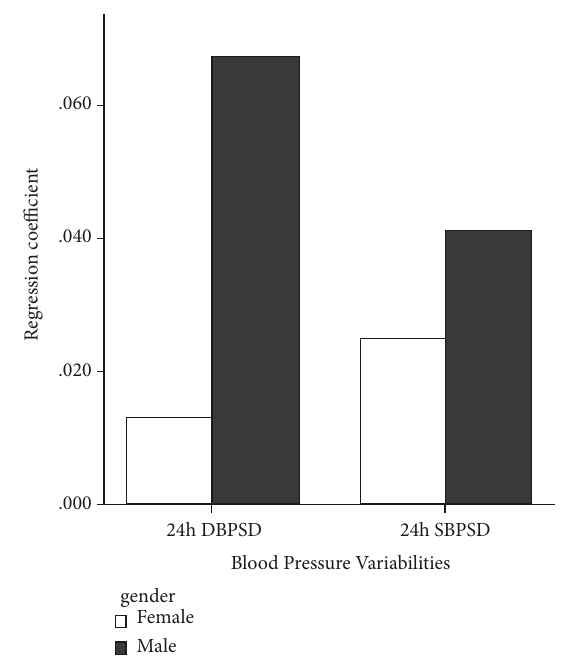
Figure 1: Comparison of linear regression coefficients between CF- PWV and BPVs in male and